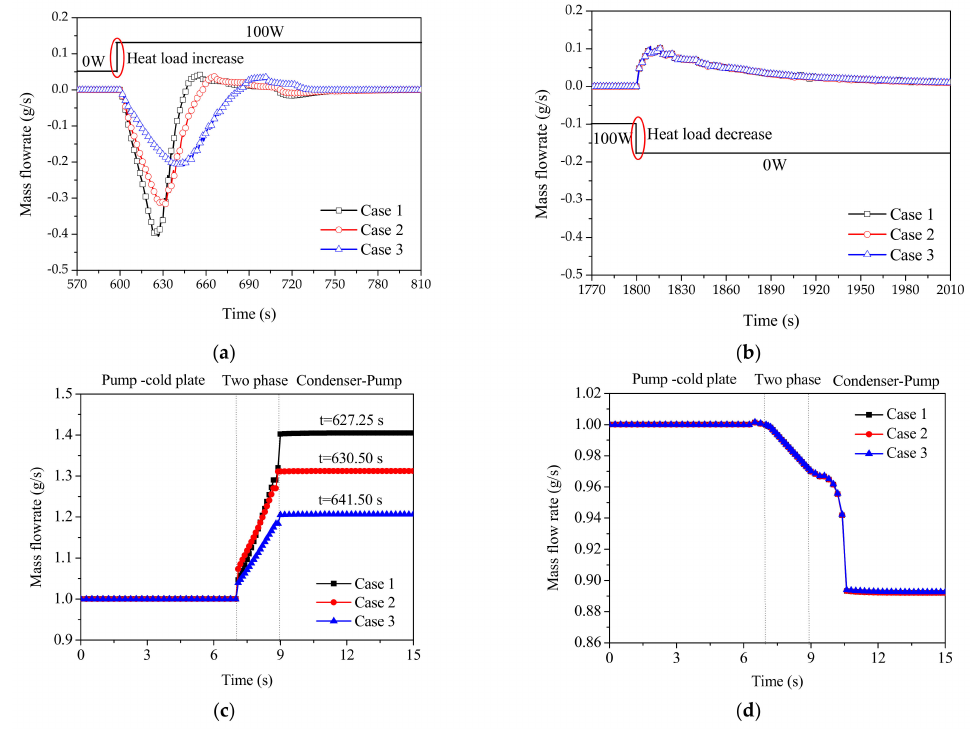
Figure 9. Temporal evolution of mass flow rate into and out of the accumulator for heat load ( a ) increase and ( b ) decrease. Profile of mass flow rate along the flow distance at the maximal flow rate values of ( c ) flowing into and ( d ) out of the accumulator with different working fluid